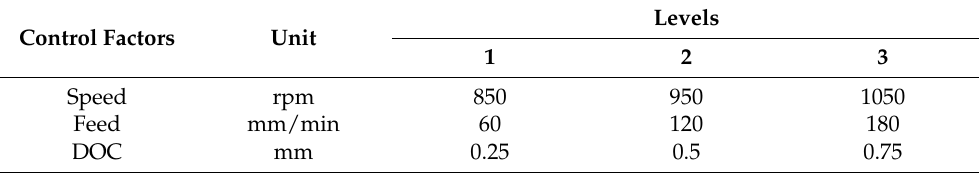
Table 1. Control factors and